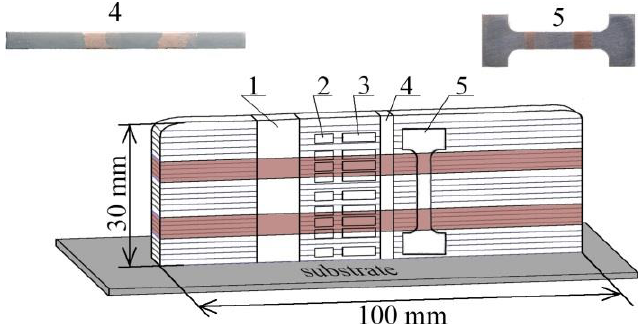
Figure 1. Scheme of cutting samples for research: 1—samples for macrostructural studies, measurement of microhardness and elemental composition; 2—areas for transmission electron microscopy; 3—areas for X-ray diffraction analysis; 4—areas for measurement of thermal linear expansion coefficient; 5—samples in the form of double blades for mechanical tensile tests.